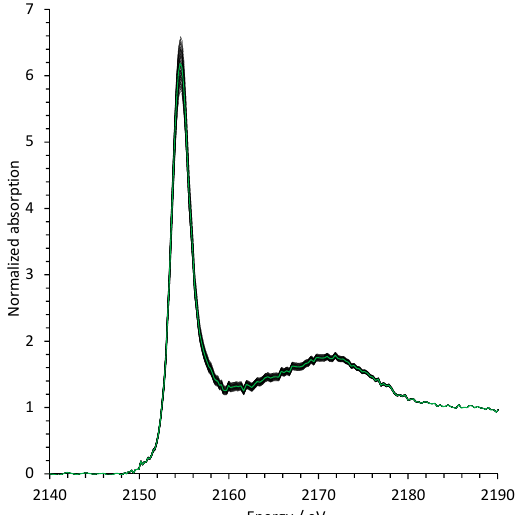
Figure 1. Normalized P K-edge X-ray absorption near-edge structure (XANES) spectrum for the 203FYM 0–28 sample. Green line: original spectrum. Black lines: 100 variants generated through Latin hypercube sampling.